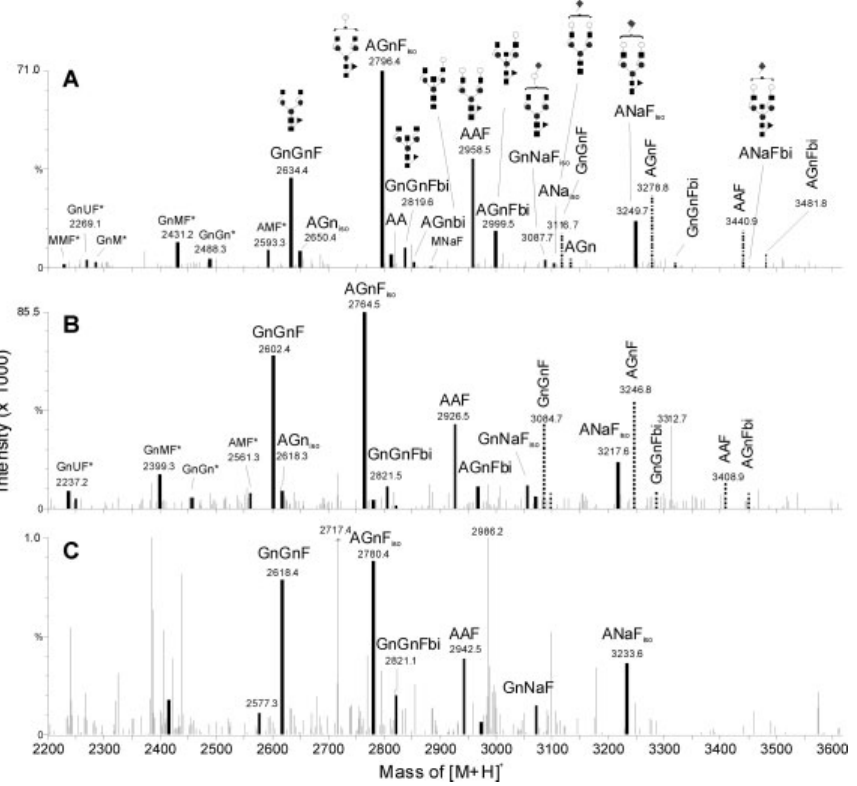
Figure 3. Glycopeptide spectra from human IgG. The relevant parts of the deconvoluted spec- tra of (A) IgG1, (B) IgG2 (plus IgG3), and (C) IgG4 are shown. Peaks assignable to the fully cleaved peptides are shown in bold lines. The partially digested glycopeptides are shown as dashed lines. Peak names with an asterisk denote species which are essentially in-source fragments as judged from charge state comparison. Peak abbreviations are given without linkage superscripts to save space. The suffix “iso” to glycan abbreviations denotes the prob- able presence of isomers, space permitting. Unassigned peaks are background, mainly from coeluting peptides of IgG, tryp- sin, or other serum